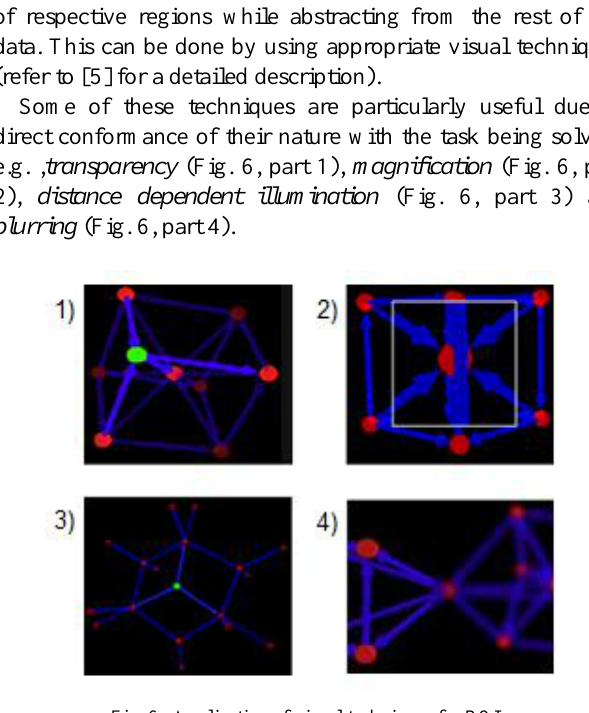
Fig. 6. Application of visual techniques for ROI.